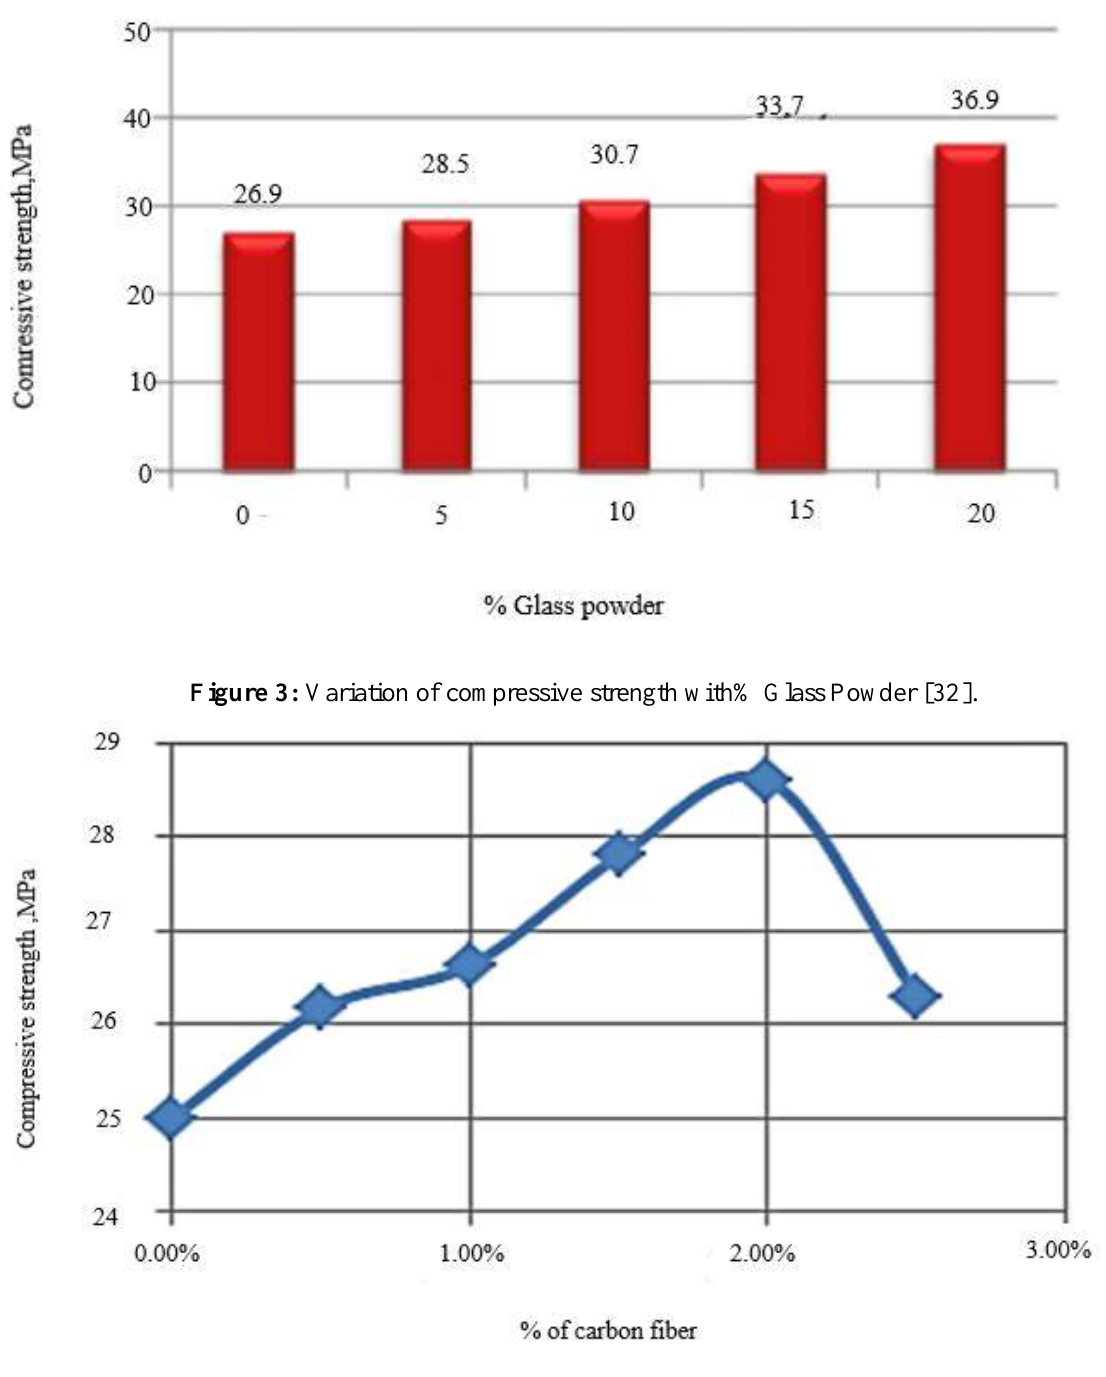
Figure 4: Variation of compressive strength with% Carbon Fiber